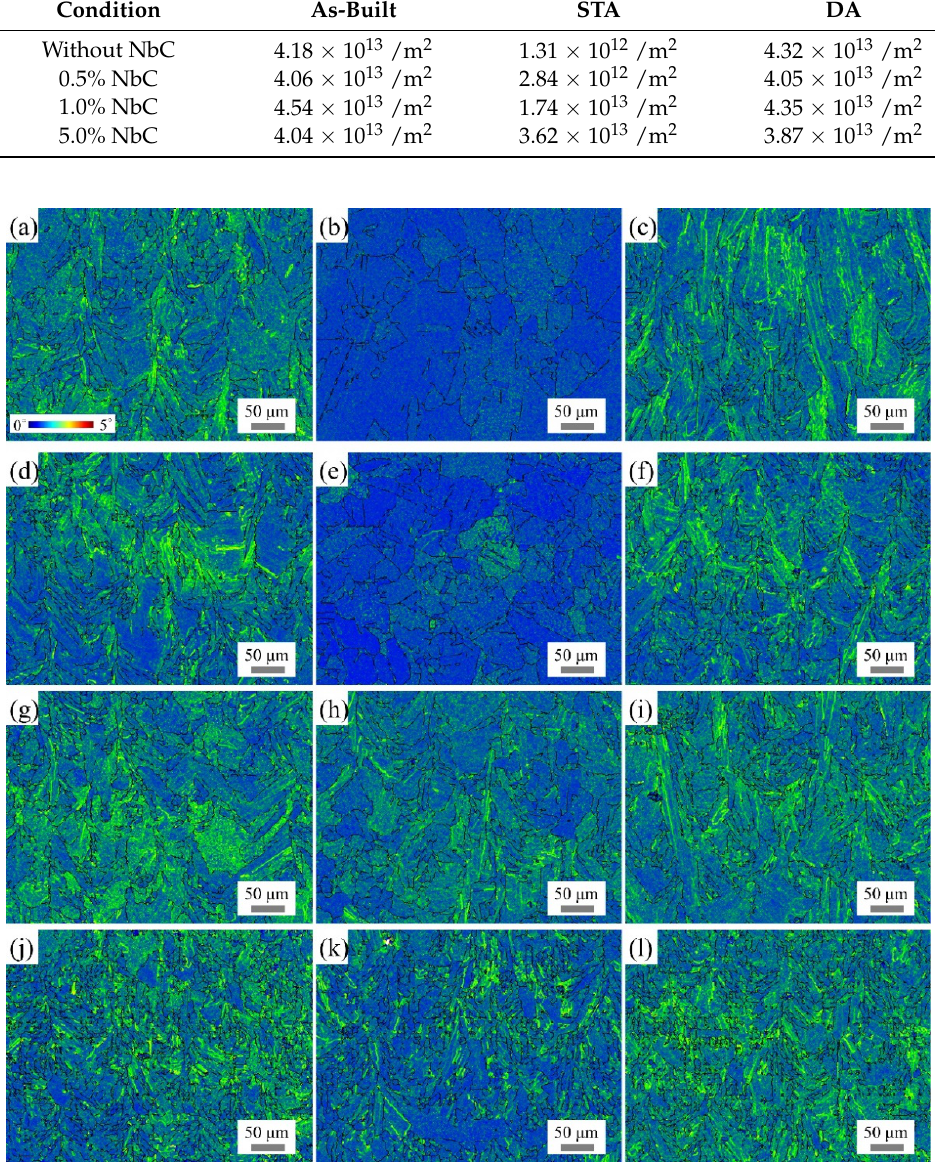
Figure 9. KAM map of different specimens. ( a ) as-built without NbC, ( b ) STA without NbC, ( c ) DA without NbC, ( d ) as-built with 0.5% NbC, ( e ) STA of 0.5% NbC, ( f ) DA of 0.5% NbC, ( g ) as-built of 1.0% NbC, ( h ) STA of 1.0% NbC, ( i ) DA of 1.0% NbC, ( j ) as-built of 5.0% NbC, ( k ) STA of 5.0% NbC, and ( l ) DA of 5.0% NbC. Table 6. Overall GND density of different specimens.